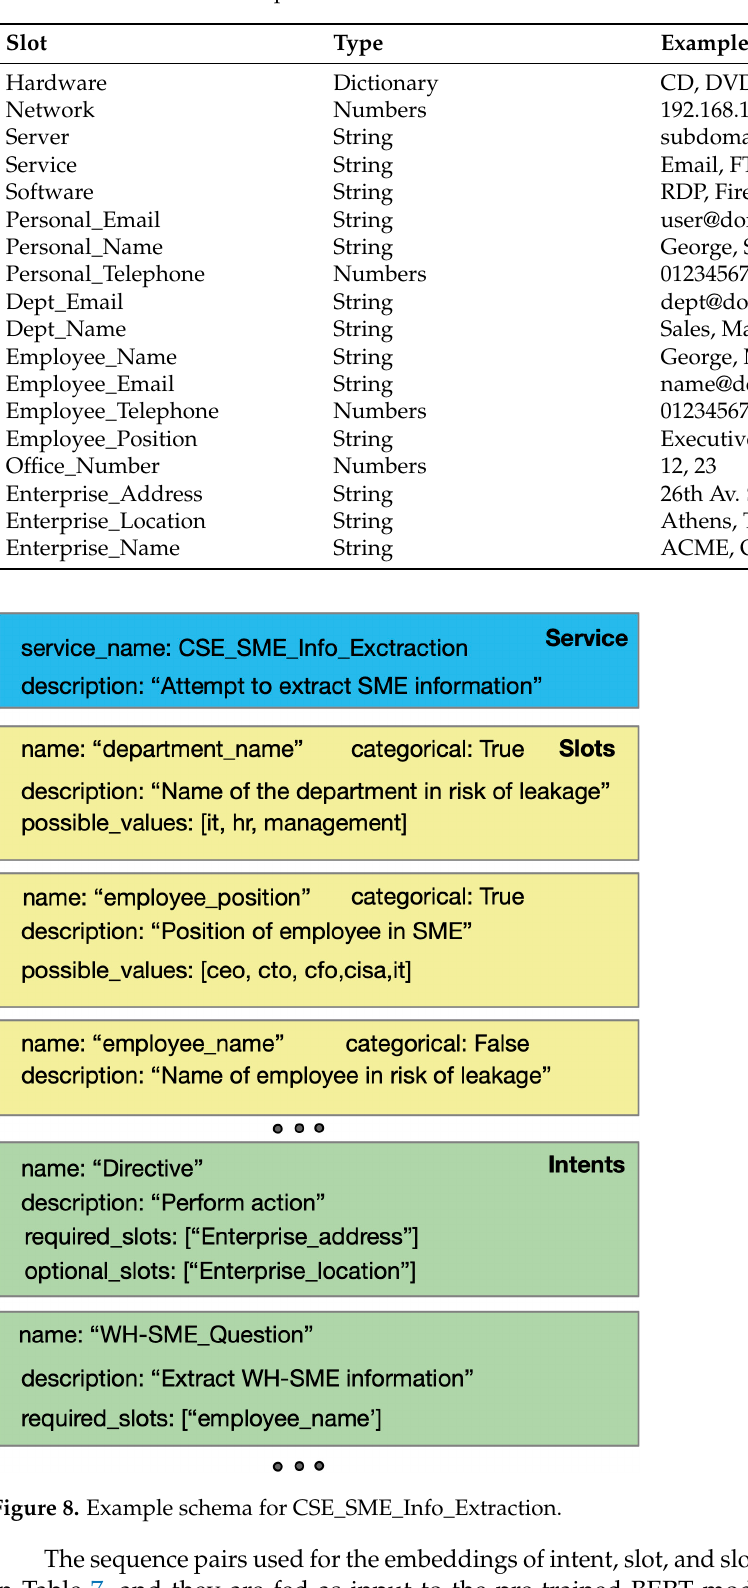
Table 6. Slots in SG-CSE Corpus.